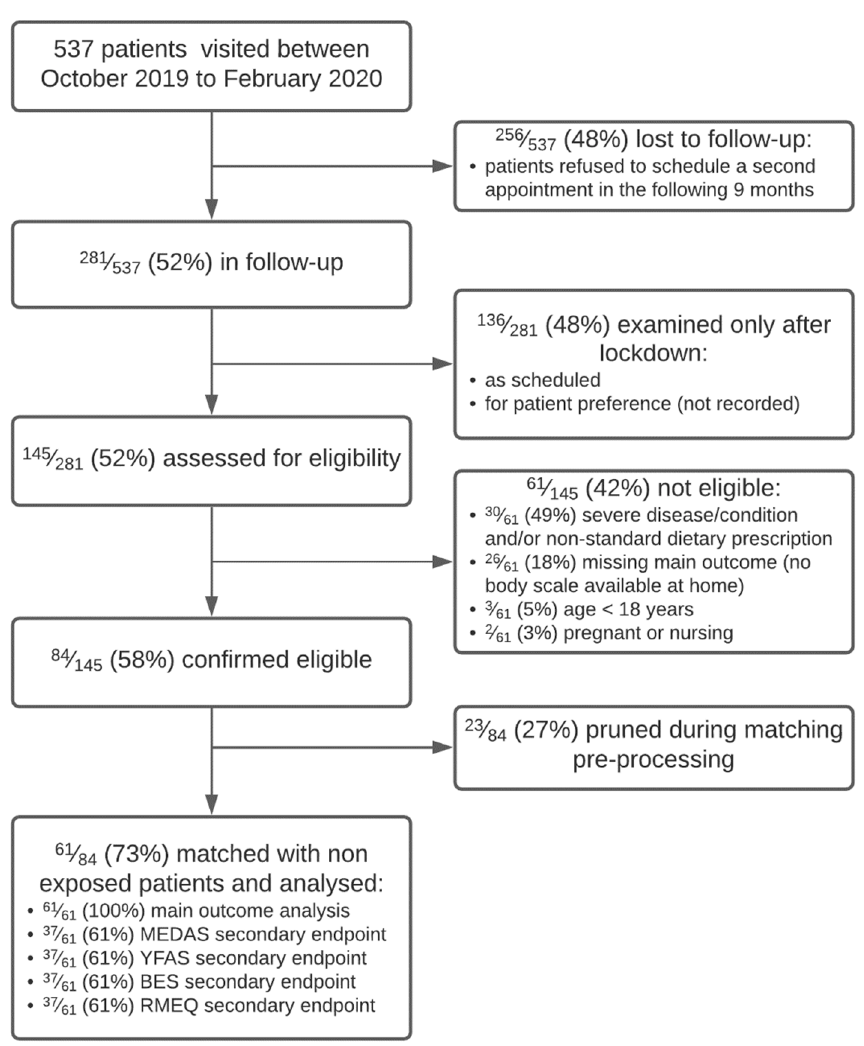
Figure 1. CONSORT participant flow diagram.